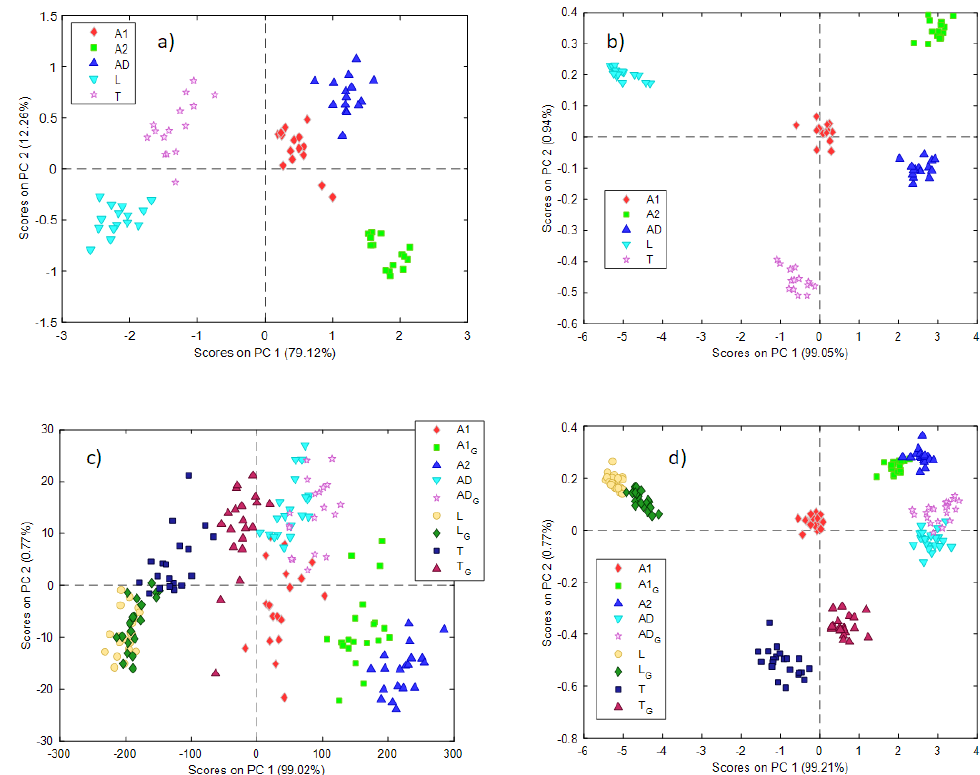
Figure 3. Scores plots for the two first PCs obtained with the PCA models using the ( a ) NeoSpectra MDK with non-ground data, ( b ) SCiO with non-ground data, ( c ) NeoSpectra MDK with ground and non-ground data, ( d ) SCiO with ground and non-ground data. A ‘G’ in the label indicates ground insect powder.